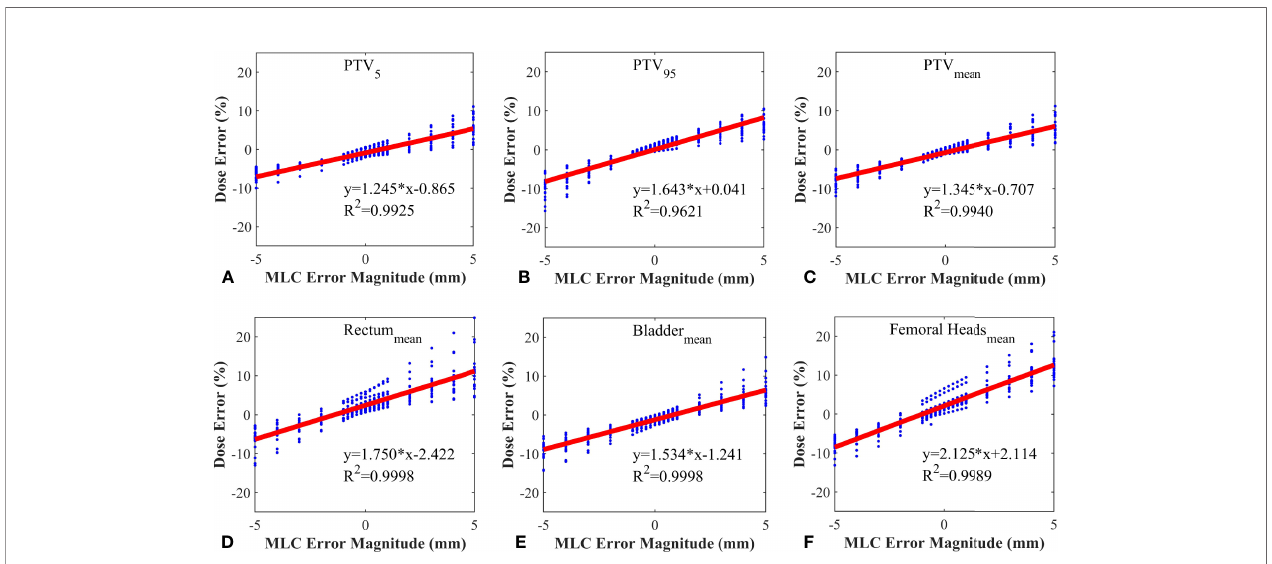
FIGURE 4 | Correlation between dose error and systematic MLC error in different DVH metrics. (A) PTV 5 ; (B) PTV 95 ; (C) PTV mean ; (D) Rectum mean ; (E) Bladder mean ; (F) Femoral Heads mean .